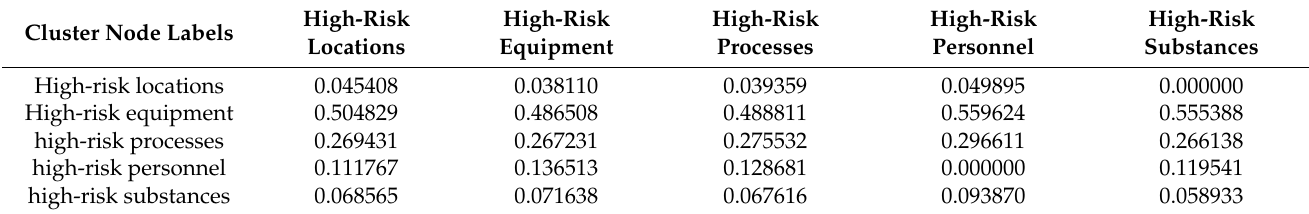
Table 4. Cluster matrix